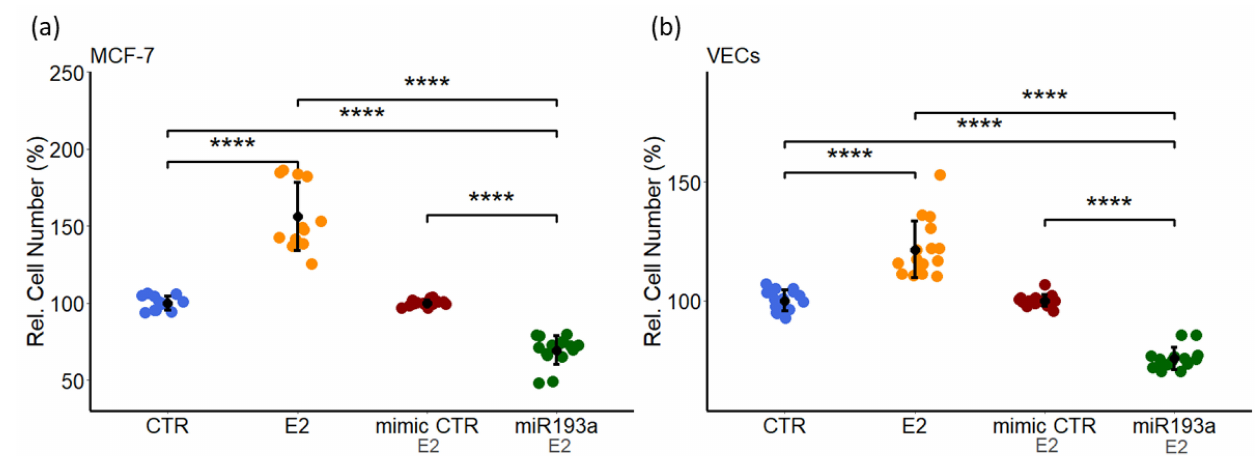
Figure 10. miRNA193a-3p abrogates Estradiol (E2) induced proliferation of MCF-7 and VECs. Cells transfected with or without miR mimic control (mimic CTR) or miR193a-3p (miR193a) were treated with 10 nM E2 or its vehicle (DMSO) as control (CTR). Cell proliferation assessed by counting of MCF-7 ( a ) and VECs ( b ) after 3 days of treatment. Data represent the mean ± SD of at least three independent experiments in triplicates or quadruplicates. p < 0.0001 **** compared to the respective